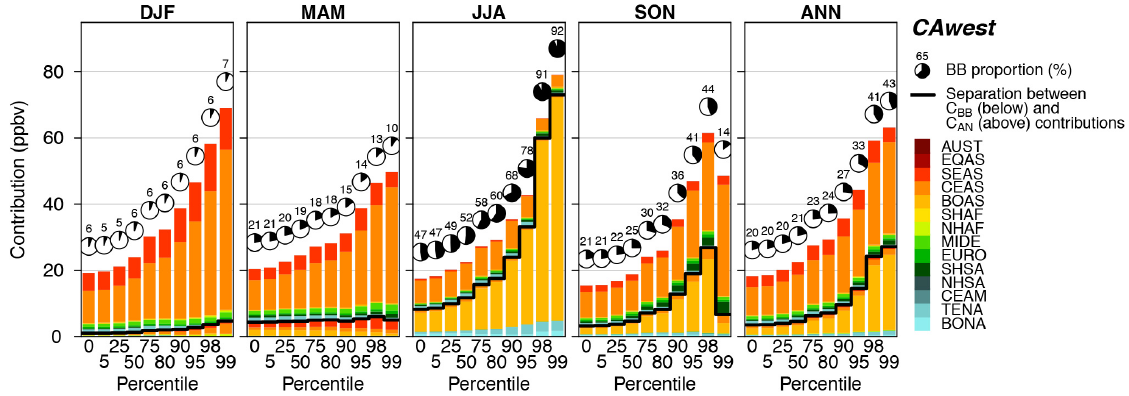
Figure 18. Same as Fig. 16 for the CAwest cluster. Note that the much lower BB contribution during fall in CO > 99 is due to a low number of points.